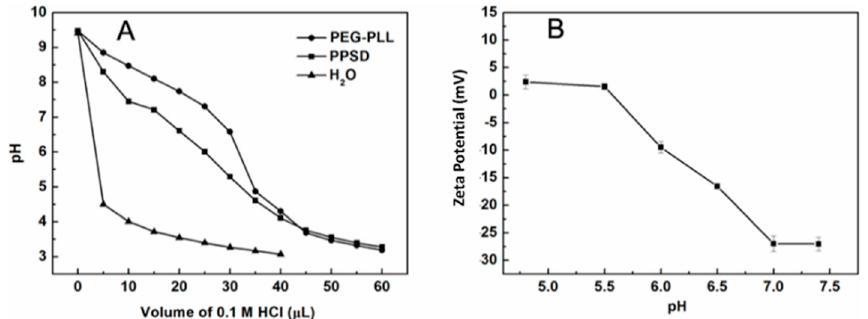
Figure 1. pH sensitivity of PPSD: ( A ) pH buffer capacity titration of PPSD; ( B ) Zeta potential of PPSD solution at different pH.